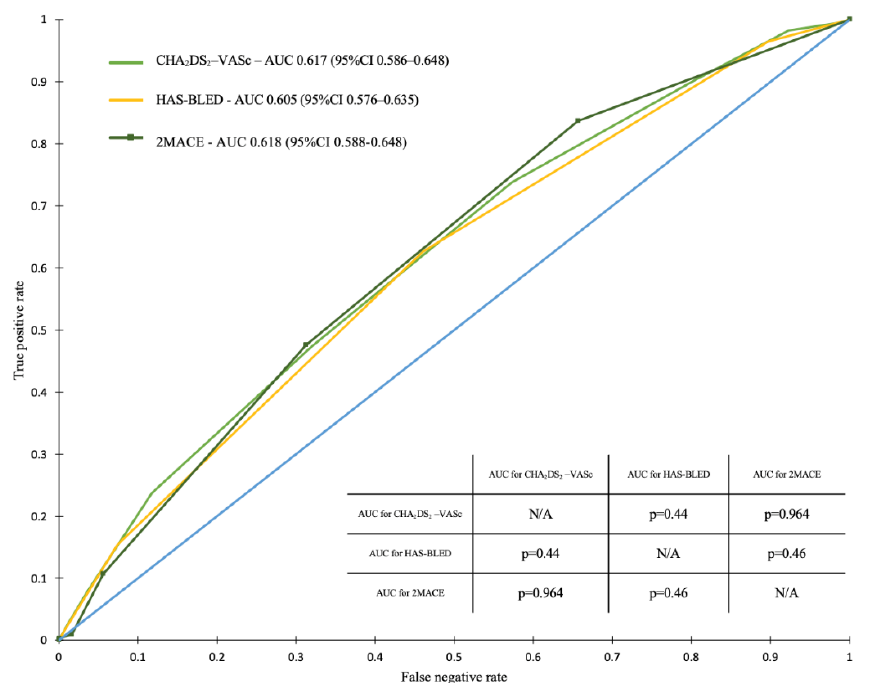
Figure 4. Receiver operating characteristic curves for the CHA 2 DS 2 -VASc, HAS-BLED, and 2MACE scores in predicting total mortality in the group of patients with atrial fibrillation. The inner table shows the p -values for comparisons between AUCs for the assessed scores. Abbreviations: AUC, area under the curve; CI, confidence interval; N/A, not